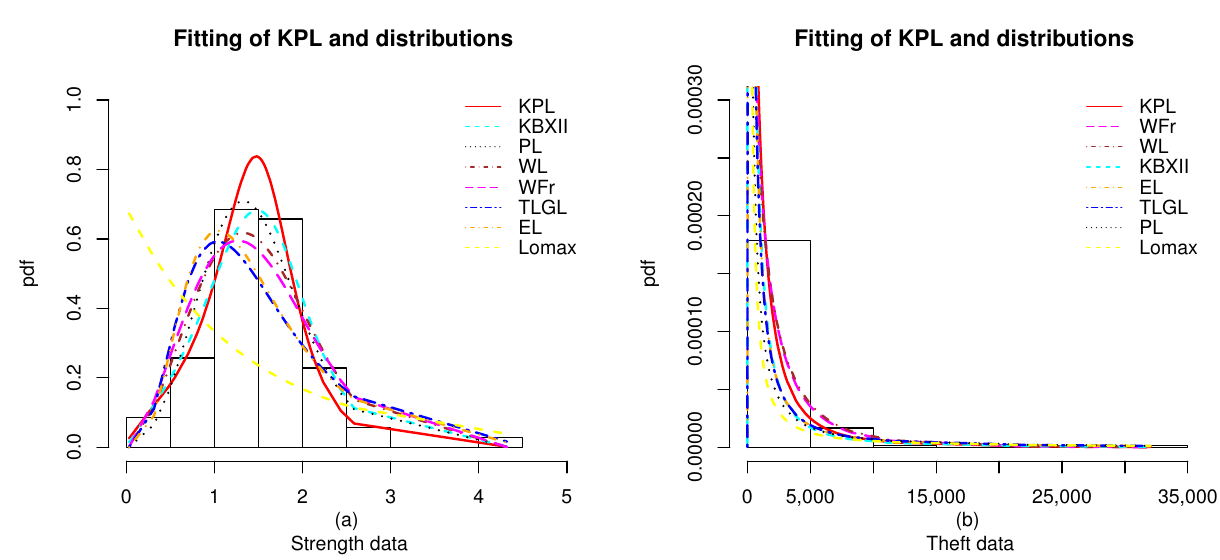
Figure 3. Fitted pdf curves of the distributions to the histograms for ( a ) data set 1 and ( b ) data set 2. Among all the listed distributions, the KPL distribution has a better fit for the data considered. We confirm this visual result by plotting the Probability-Probability (PP) plots of the estimated distributions in Figures 4 and 5 for data sets 1 and 2, respectively.